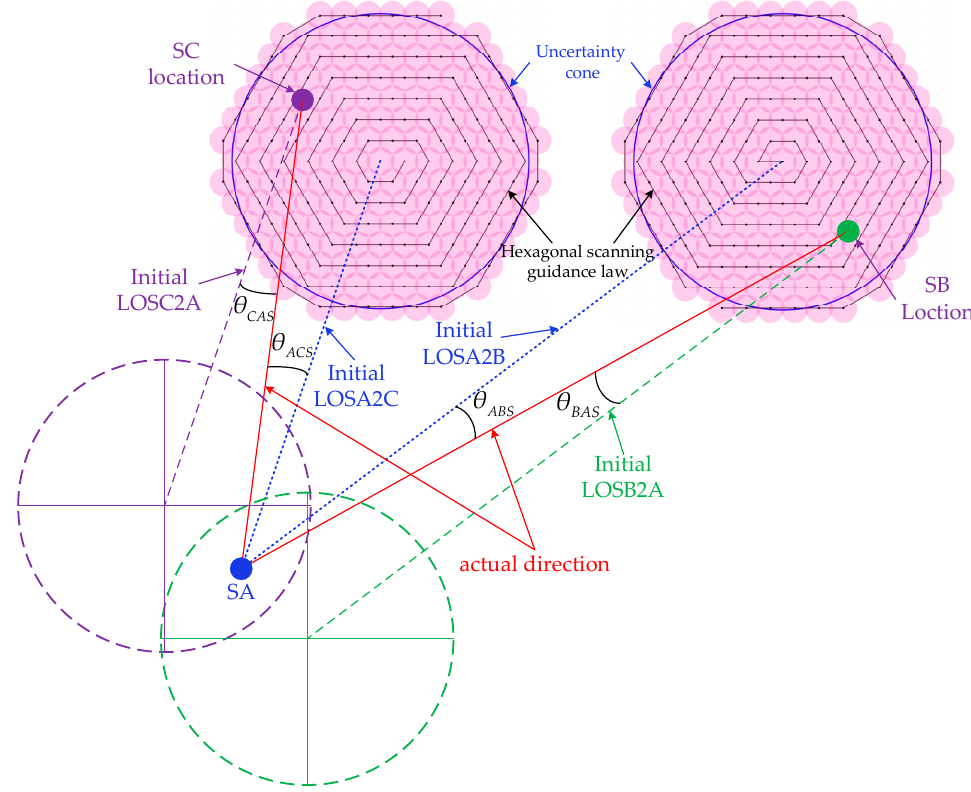
Figure 4. Schematic diagram of scanning for the uncertainty cone. Where initial LOSA2C and LOSA2B denote the initial line of sight of the T1 and T2 of SA towards SC and SB, respectively; initial LOSC2A and initial LOSB2A denote the initial line of sight of the T2 of SC and T1 of SB towards SA; θ ABS and θ ACS denote the angle offset between initial LOS of SA and actual direction toward SC and SB, respectively; θ CAS denotes the angle offset between the initial LOS of SC and the actual direction toward SA; θ BAS denotes the angle offset between the initial LOS of SB and the actual direction toward SA.